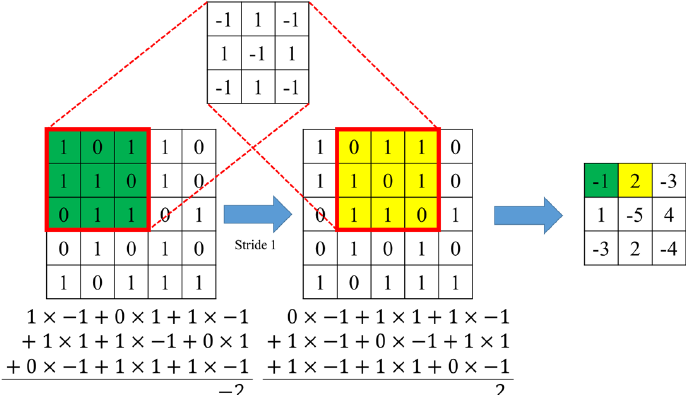
Figure 4. Schematic diagram of the convolutional layer operation .